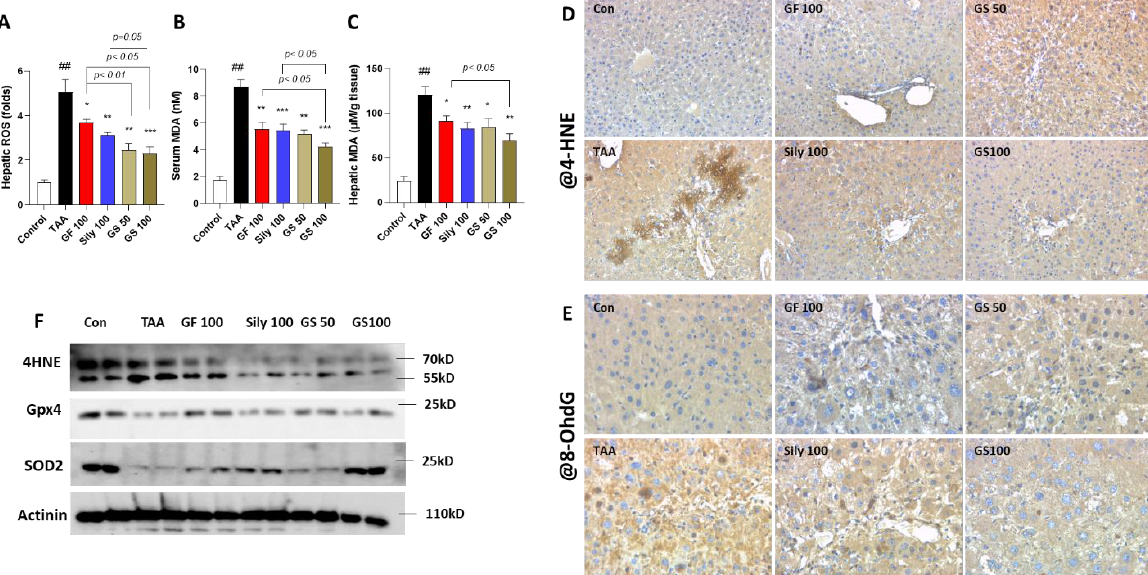
Figure 3. Administrations with GS exert amelioration of hepatic tissue oxidation. ( A ) Hepatic ROS levels. ( B ) Serum MDA levels. ( C ) Hepatic MDA levels. ( D ) IHC analysis against 4-HNE and ( E ) 8-OHdG. ( F ) Western blot analysis of the antioxidant-related proteins. Data were expressed by mean ± S.E.M. ## p < 0.01 for Control vs. TAA. * p < 0.05, ** p < 0.01, and *** p < 0.001 for TAA vs. drug treatments ( n = 4 for IHC analysis, n = 6 – 8 for biochemistry analysis, n = 4 for Western blot analysis). Images were captured by light microscopy conditions (100× magnifications).